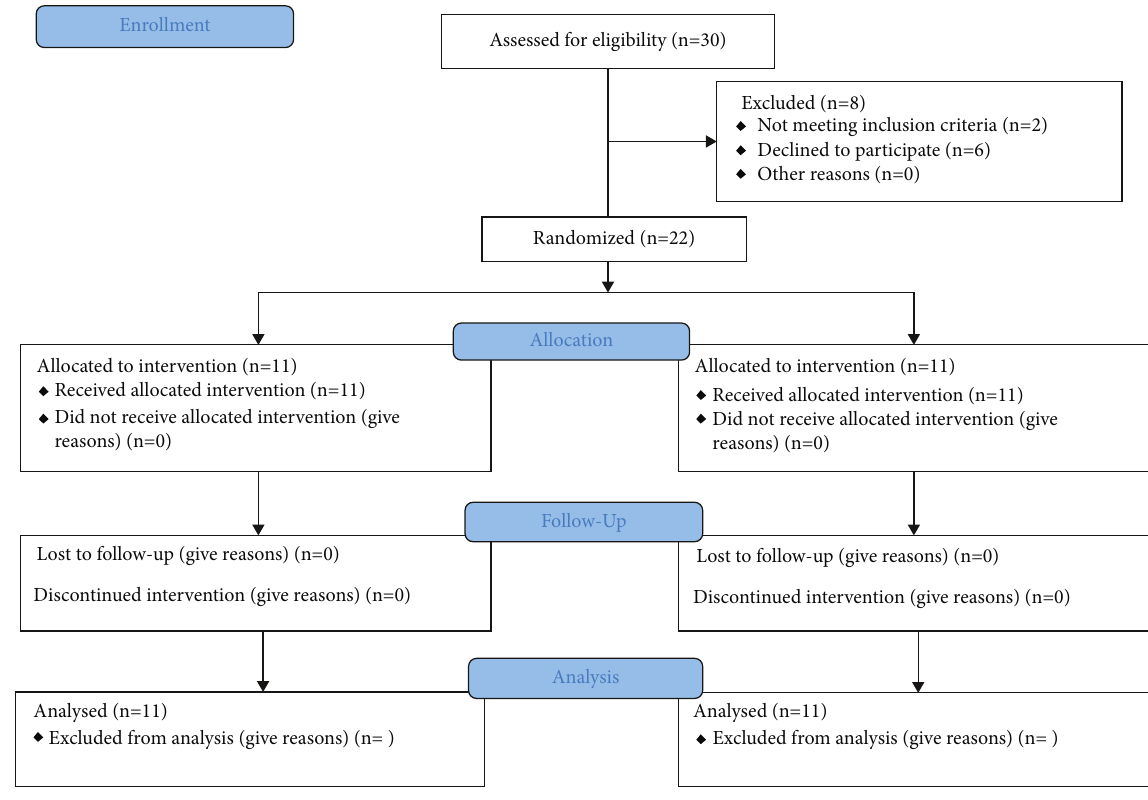
Figure 8: Flow diagram. Table 1: Comparison between retention forces ( N ) in the two groups.